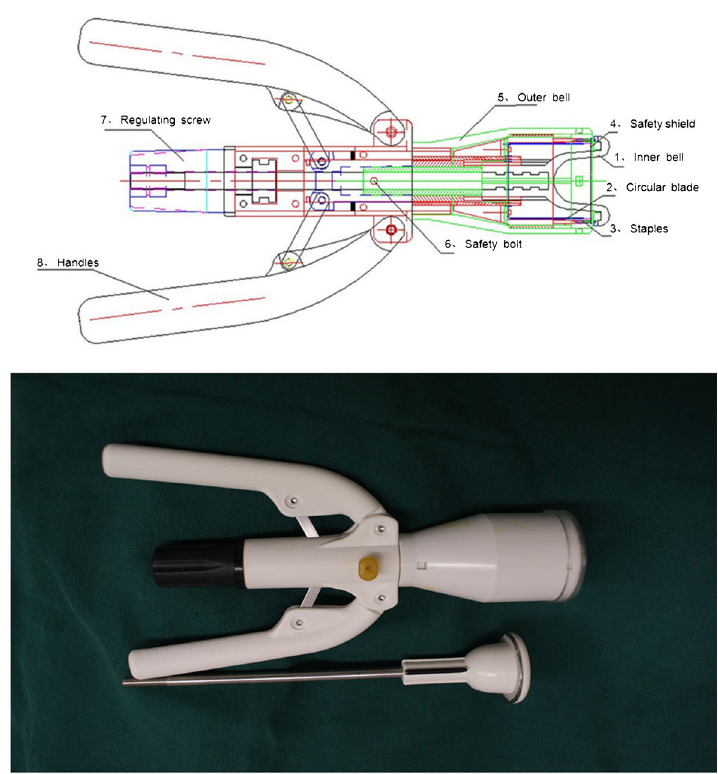
Figure 1. The circular stapler comprises an inner bell and an outer bell. The inner bell is designed to protect the glans. The outer bell has two cutting trigger handles, a regulating screw, a circular blade, staples, a safety shield, and a bolt. The circular blade and staples are hidden in the outer bell and protected by the safety shield and